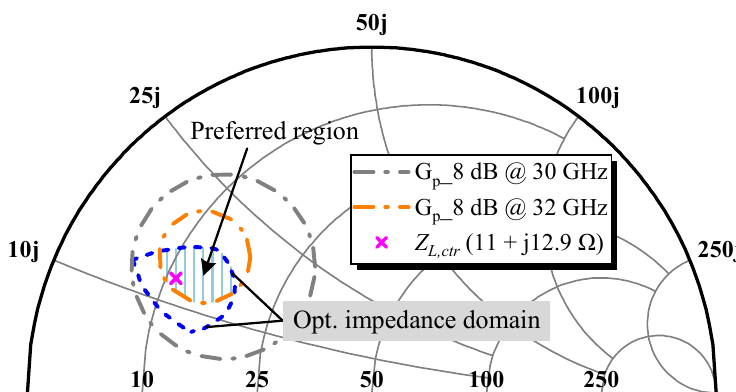
Figure 3. Preferred region in the optimal impedance domain.